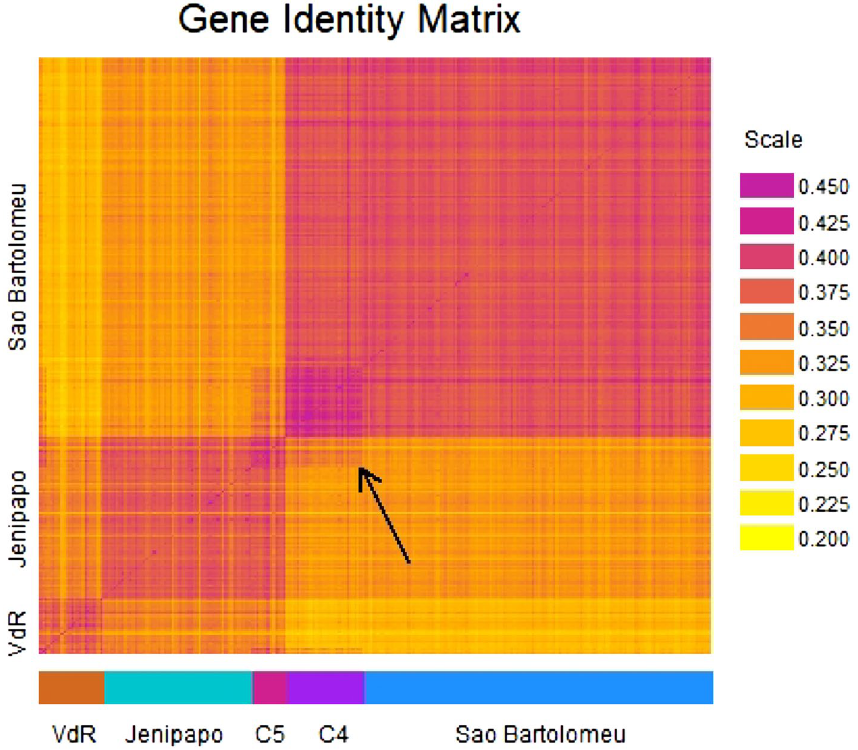
Figure 4. Heatmap of Gene Identity Matrix. Each ‘pixel’ on the diagonal corresponds to the gene identity within an infrapopulation. Each ‘pixel’ on the off-diagonal corresponds to the gene identity between two infrapopulations. Rows and columns are ordered using the results from K-means clustering with K = 5. VdR = Volta do Rio, C4 is a subgroup of infrapopulations sampled in São Bartolomeu and C5 is a subgroup of infrapopulations sampled in Jenipapo. The arrow identifies a block of increased gene identity between infrapopulations in C4 and